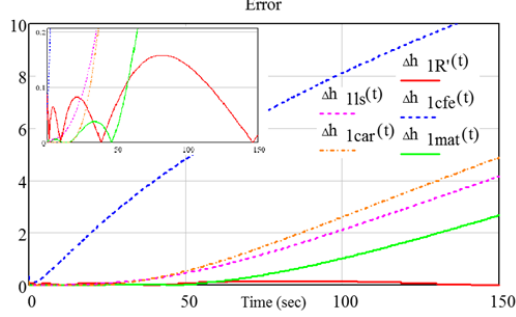
where h 1 (t) - exact time response; h 1 R ‘ (t) - time response by RIM method; h 1 cfe (t) - time re- sponse by CFE method; h 1 mat (t) - time response by Matsuda’s method; h 1 ls (t) - time response Least-squares method; h 1 car (t) - time response by Carlson’s method. The approximation errors of time responses are illustrated in Fig. 2.